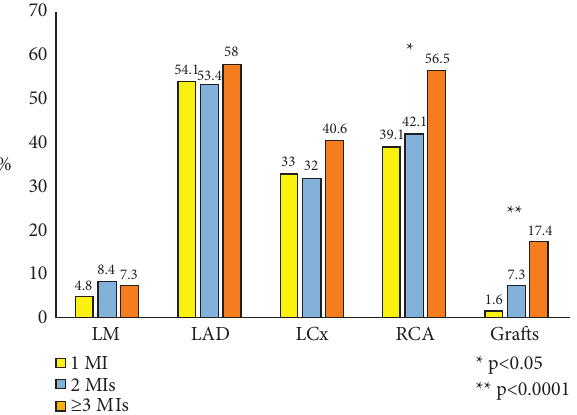
Figure 2: Frequency of coronary vessel with significant stenoses ( ≥ 50% for left main and ≥ 70% for other vessels at coronary an- giography) in the 3 groups (data on 1456 patients with angio- graphic data available). LAD: left anterior descending; LCx: left circumflex; LM: left main; RCA: right coronary